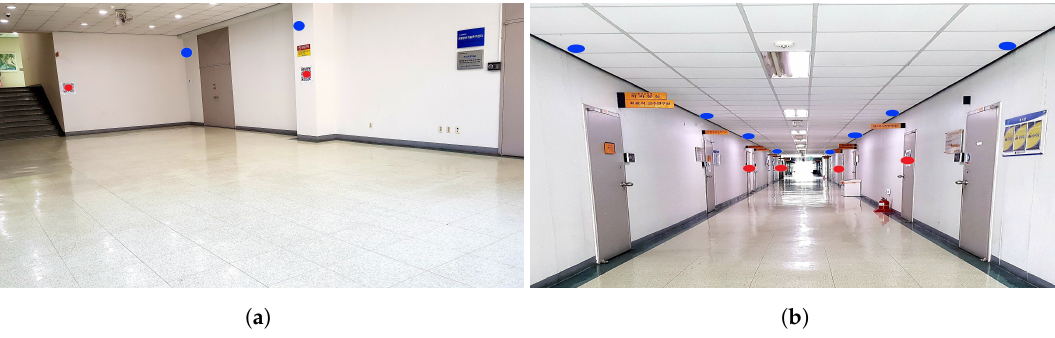
Figure 12. Experiment testbeds equipped with BLE beacons and QR marker. ( a ) Hall of 3rd floor. ( b ) Corridor of the 8th floor.